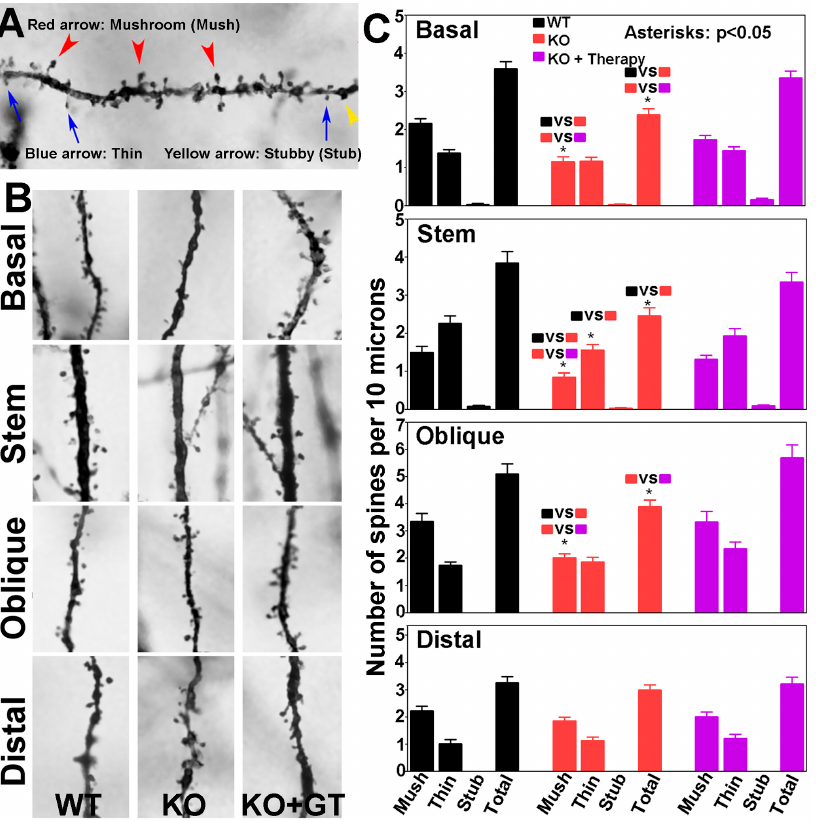
Figure 8. CA1 pyramidal neurons of cerebral cortex-specific POMT2 knockout mice exhibit reduced dendritic spine density which was rescued by postnatal gene therapy. The brains of five- to six-month old cerebral cortex-specific POMT2 knockout mice were processed for Golgi-staining. Spines on basal and apical dendrites, including those on the apical stems, of CA1 pyramidal neurons were counted. ( A ) Examples of mushroom, thin, and stubby spines; ( B ) representative segments of basal, stem, oblique, and distal dendrites in wildtype mice ( left ), knockout mice ( middle ), and AAV9-POMT2-treated knockout mice ( right ); and ( C ) number of mushroom, thin, stubby, and total spines per 10 µ m lengths of basal dendrites, apical stem, and apical oblique and distal branches. Note mushroom spines were reduced in basal dendrites, apical stem, and oblique branches of the knockout mice. This defect was rescued in AAV9-POMT2-treated knockout mice. Thin spines on apical stems were also reduced in the knockout mice. Thus, the reduced spine density in the knockout mice was mainly caused by reduction of mushroom spines. Interestingly, AAV9-POMT2 treated knockout mice showed no significant difference from the wildtype mice indicating that postnatal gene therapy rescued faulty spines. Spine density on distal branches was not affected in the knockout mice, and was a feature that was not affected by gene therapy. These results indicate that O-mannosyl glycosylation deficiency affects dendritic spine morphology which is largely corrected by postnatal gene therapy. Abbreviations: WT, wildtype; KO, cerebral cortex-specific POMT2 knockout; KO+GT, AAV9-POMT2 treated knockout